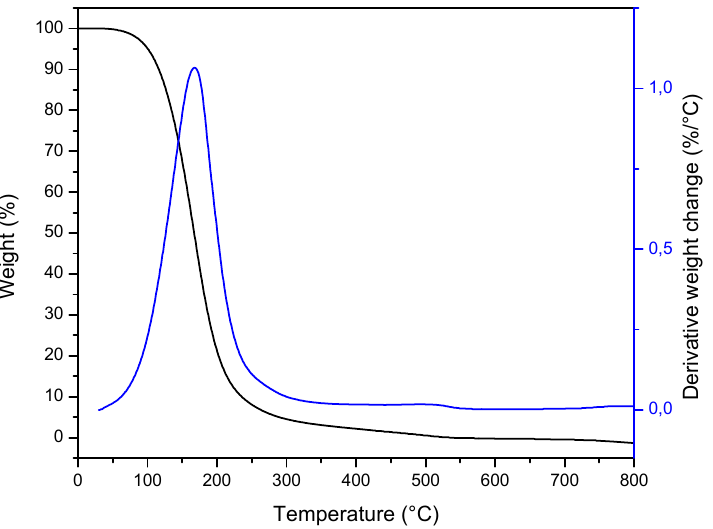
Figure 3. Thermal stability of ZEO: thermogravimetric and first-derivative of TGA curves.